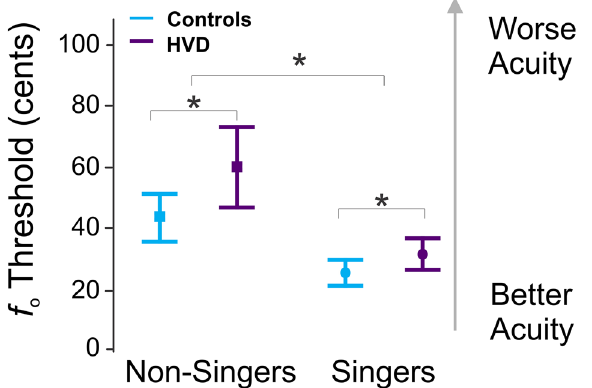
Figure 1. Auditory discrimination. The average auditory discrimination thresholds for changes in voice fundamental frequency ( f o ) in cents are shown for the control group non-singers (light blue square, left; N = 33), HVD group non-singers (dark purple square, left; N = 33), control group singers (light blue circle, right; N = 29) and HVD group singers (dark purple circle, right; N = 29). The error bars indicate 95% confidence intervals. *Indicates statistical significance at the p < .05